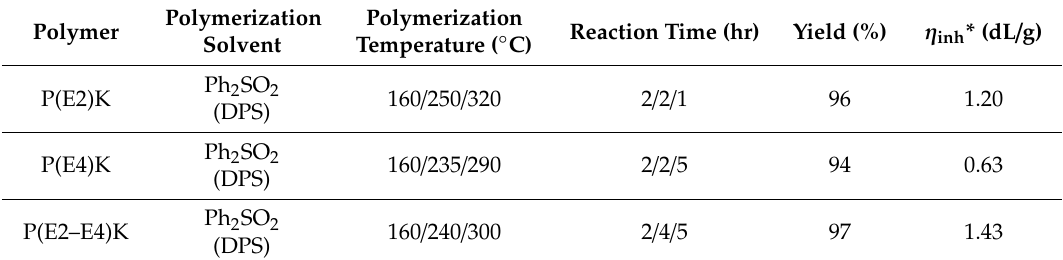
Table 2. Synthesis data for the preparation of aromatic PEEK homo and copolymers.